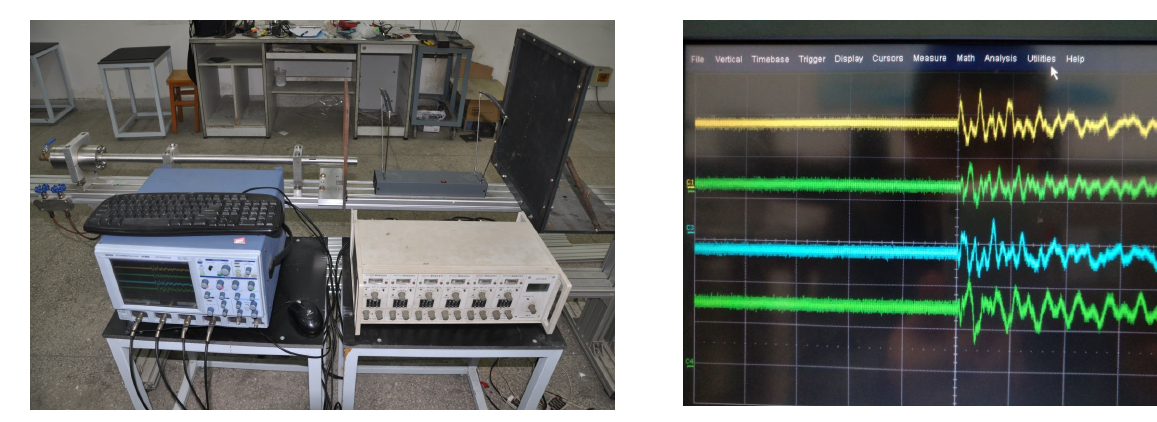
of an air gun, a velometer, a clamp and a baffle. The steel bullet is long 59mm with a weight of 12.9g and a diame- ter of 6mm. The velometer is responsible for measuring the speed of a bullet shooting. The distance between the sample plate and the gas gun is 0.5m. The impact position distance is at the boundary 65mm. Data acquisition device are consisted of a LeCroy WaveRunner 6100A oscilloscope( Teledyne LeCroy ) and a SDY2107 ultra dynamic strain me- ter signal amplifier (Electronic Technology Co., Ltd.) (see Figure 3). The sampling frequency is 10MHz.